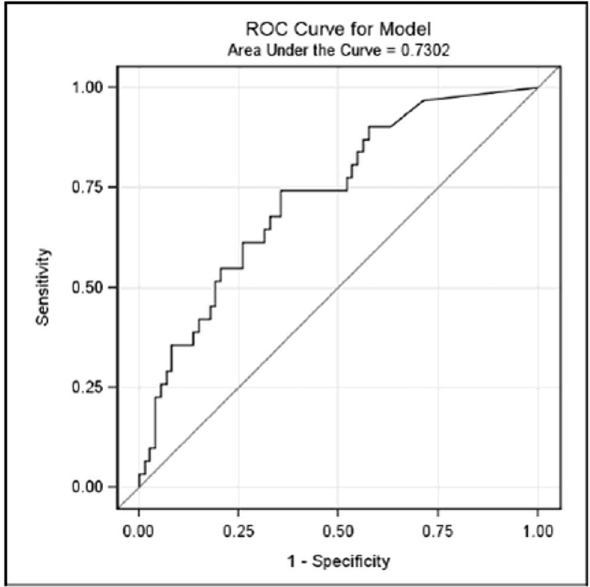
Figure 1. ROC analysis of HDV RNA levels. With a view to identifying levels of HDV viremia correlated to a higher propensity of disease progression, the ROC analysis identified 5.78 logHDV RNA (i.e. approximately 600,000 copies/mL) as the best cut-off value for predicting the development of cirrhosis (AUC=0.73) in patients with chronic